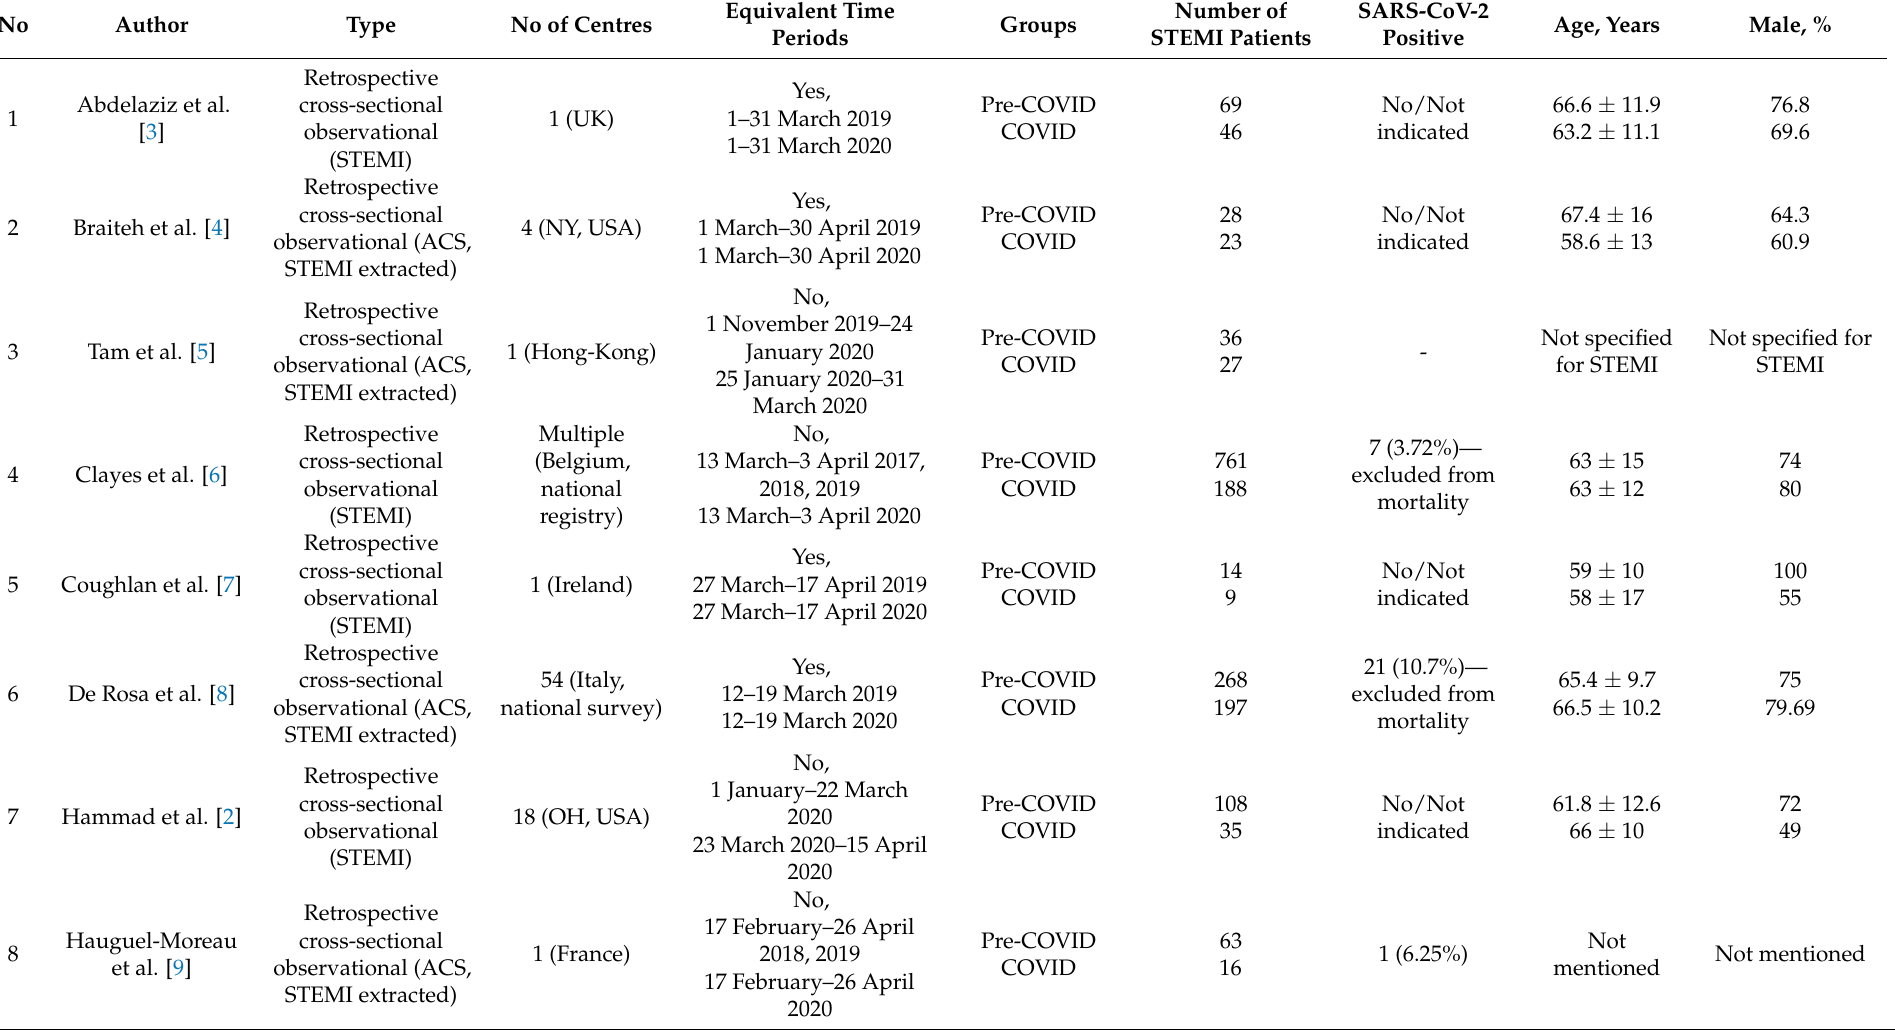
Table 1. Summary of included